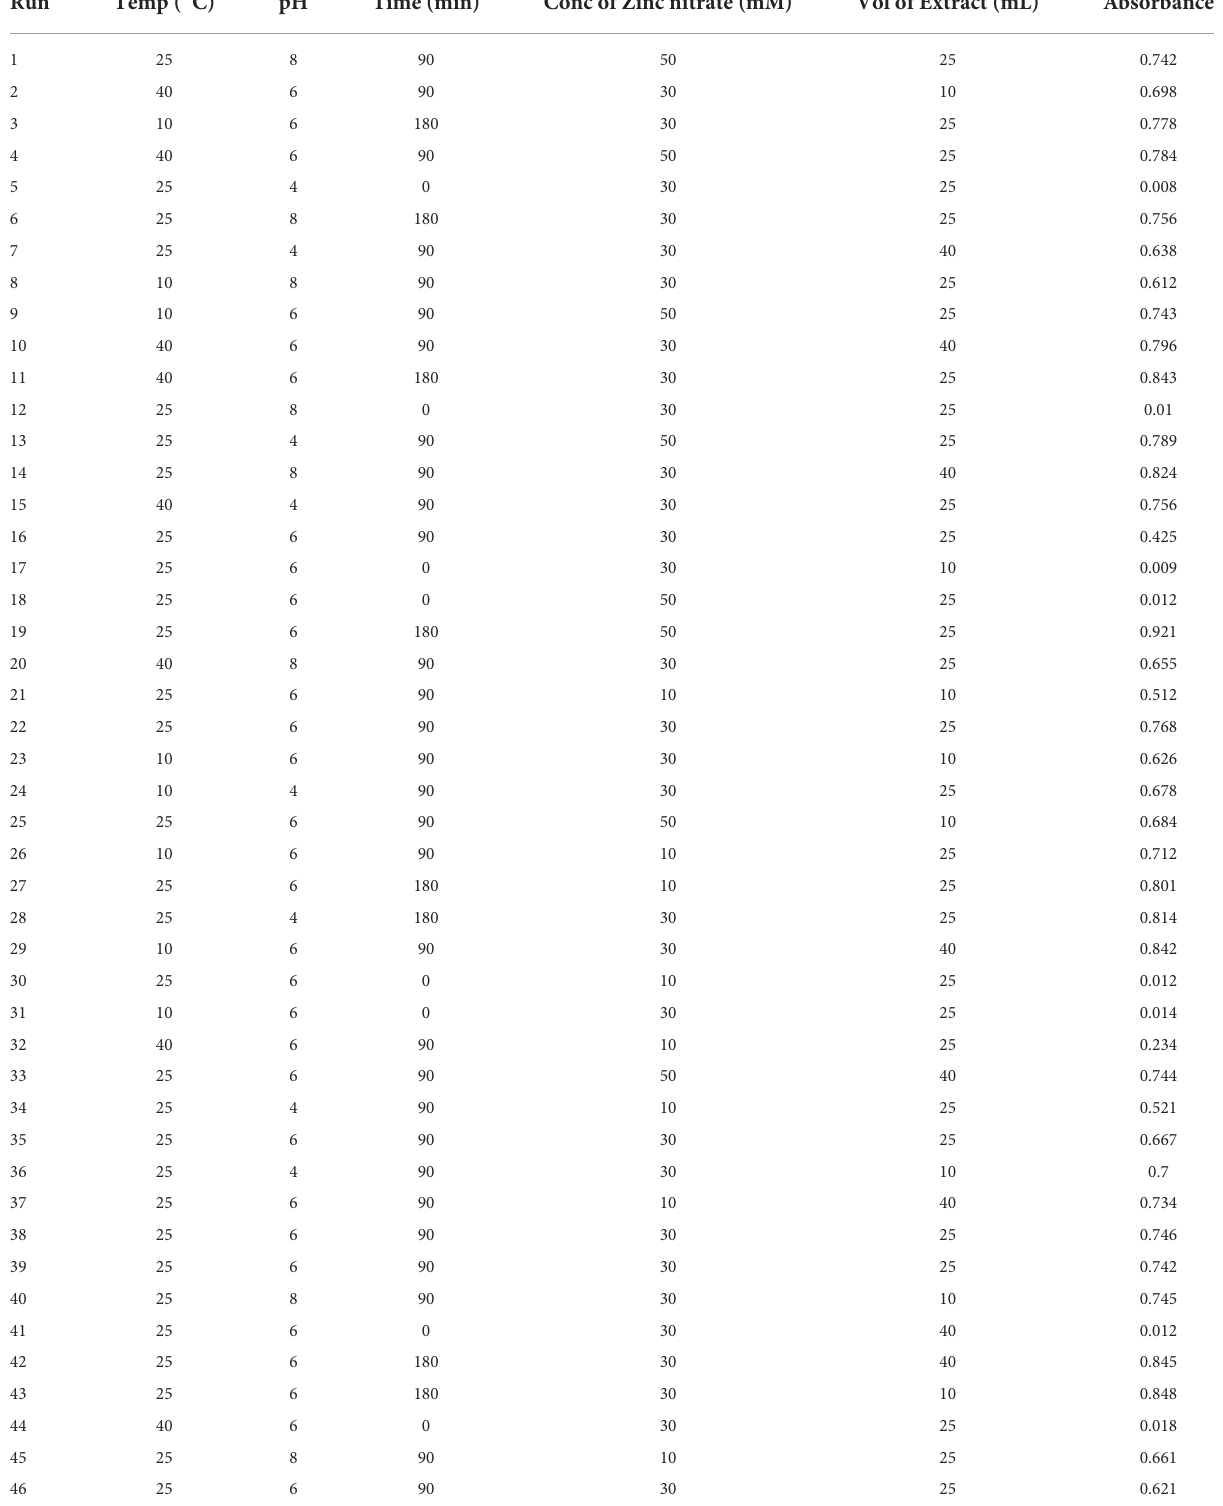
TABLE 2 Process parameters for production of biogenic ZnO NP as per Box-Behnken